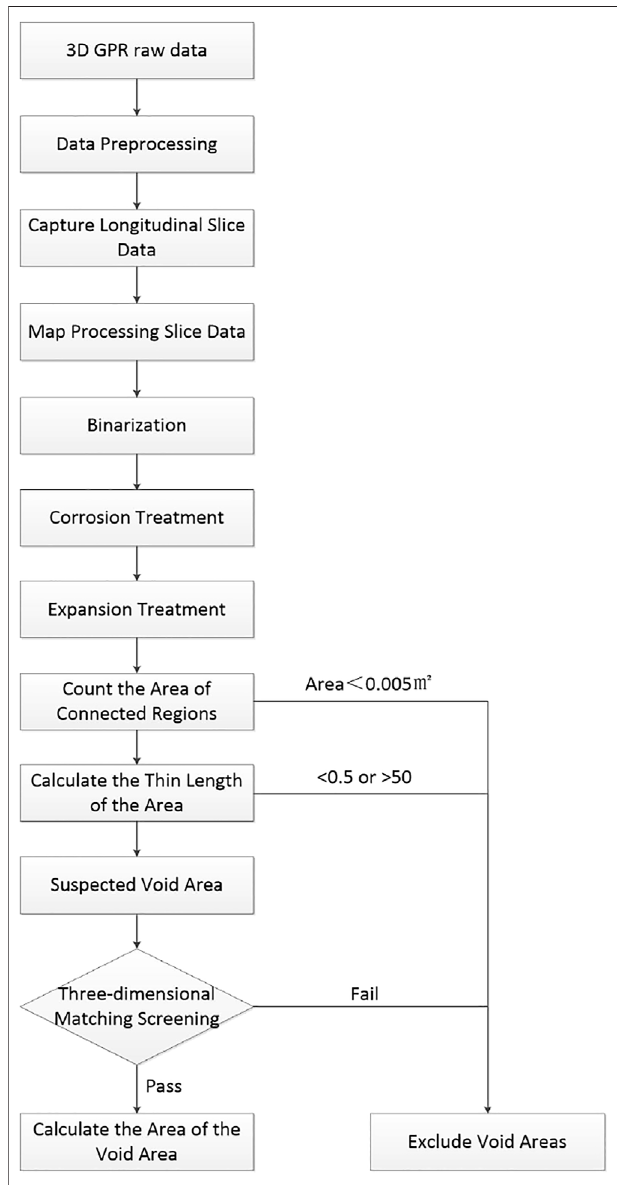
FIGURE 1 | Steps of void recognition algorithm based on the digital image processing